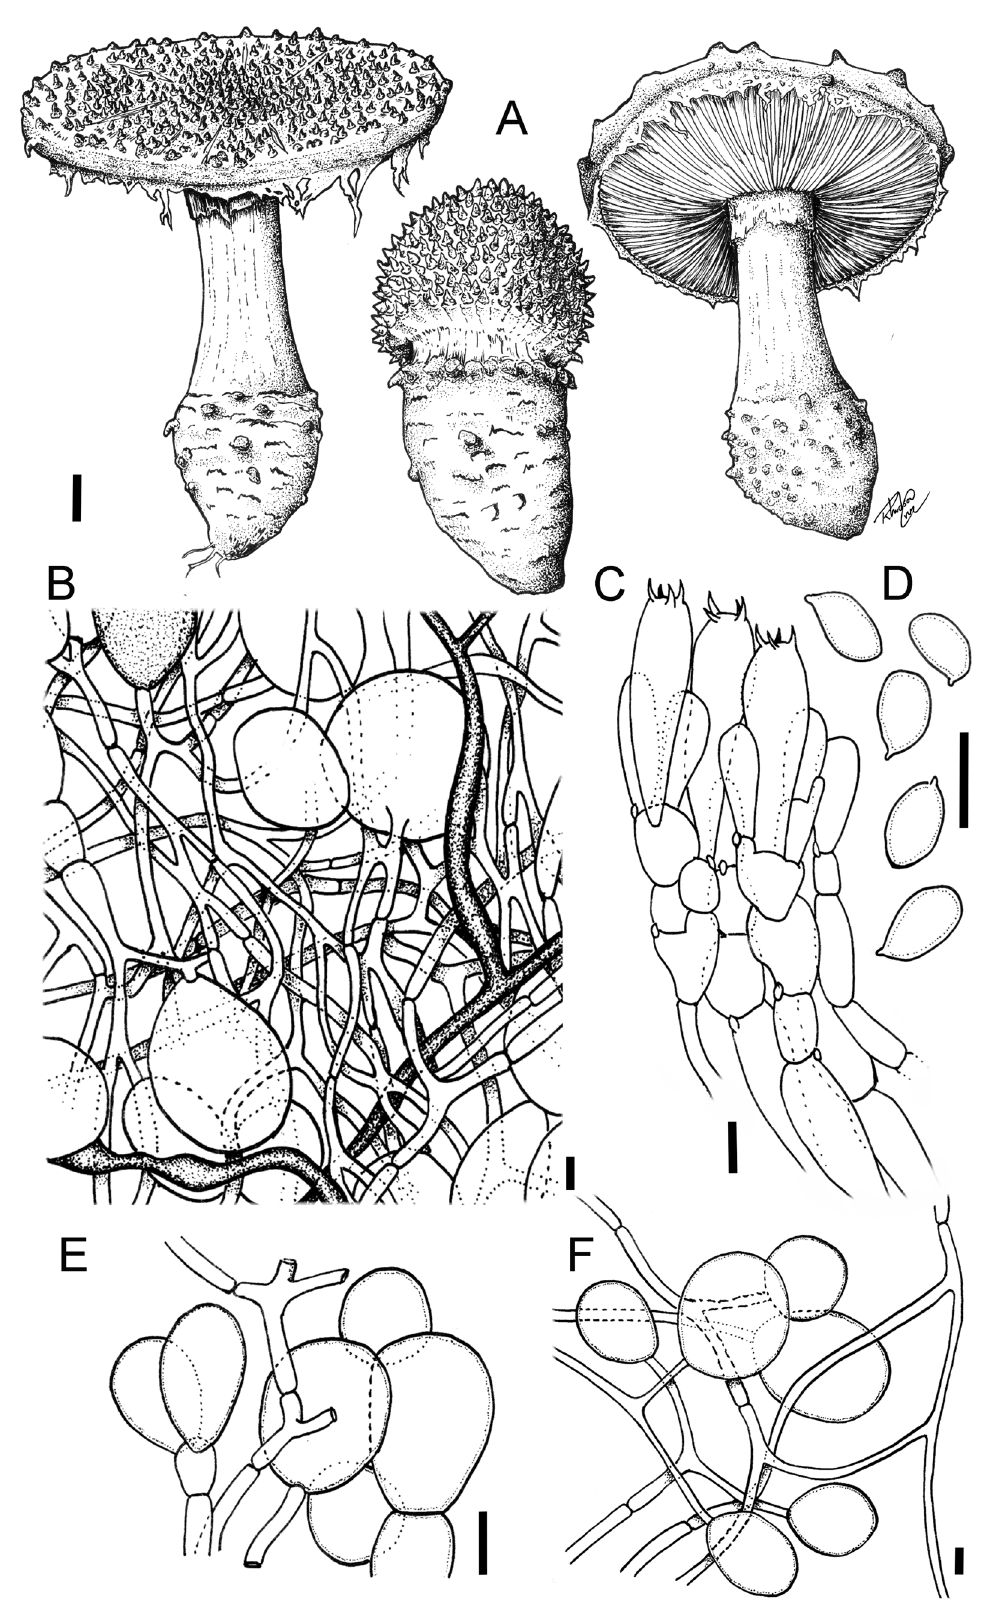
Figure 2 – Amanita dulciodora : A, basidiomata; B, universal veil remnants on pileus in longitudinal section; C, hymenium and subhymenium; D, basidiospores; E, lamellar edge cells; F, partial veil trama. Scale bars: A = 10 mm; B–F = 10 μm. Drawings by Rhudson Ferreira